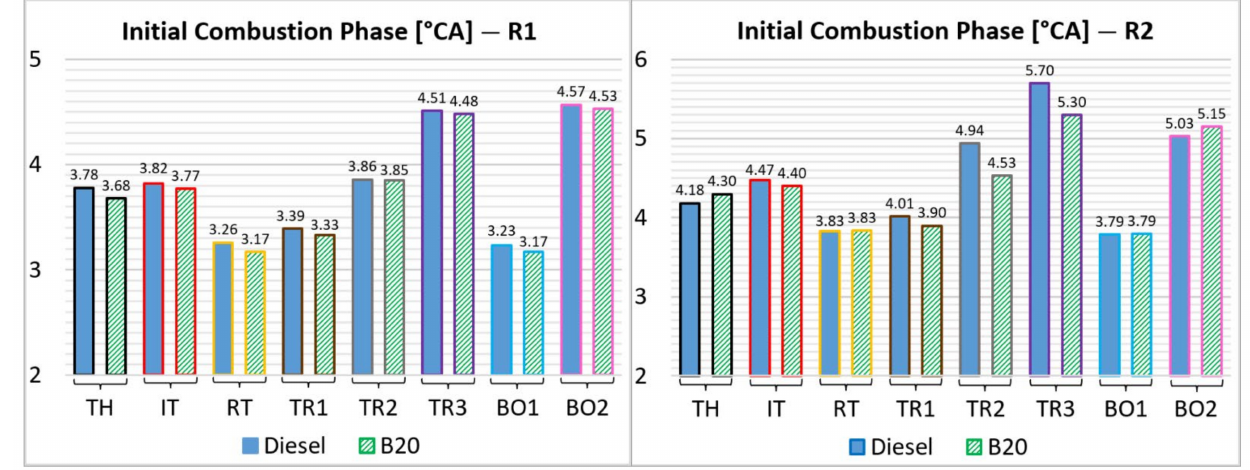
Figure 6. Initial combustion phase variation by different shapes of ROI.